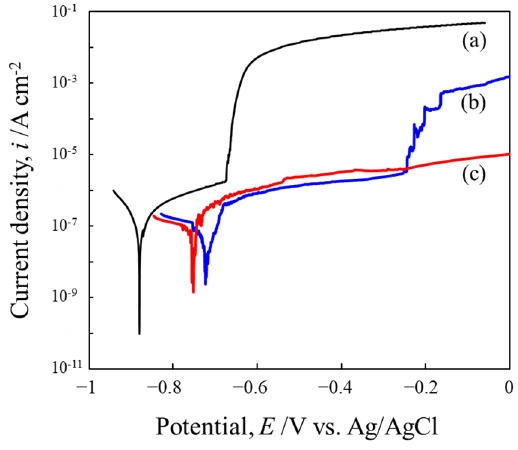
Figure 6. Potentiodynamic polarization curves of ( a ) as ‐ received specimen and specimens subjected to steam coating at ( b ) 160 °C and ( c ) 180 °C for 1 h, after immersion in NaCl solution for 0.5 h. Table 2. Fitting results of potentiodynamic polarization curves of as ‐ received and film ‐ coated specimens immersed in NaCl solution.